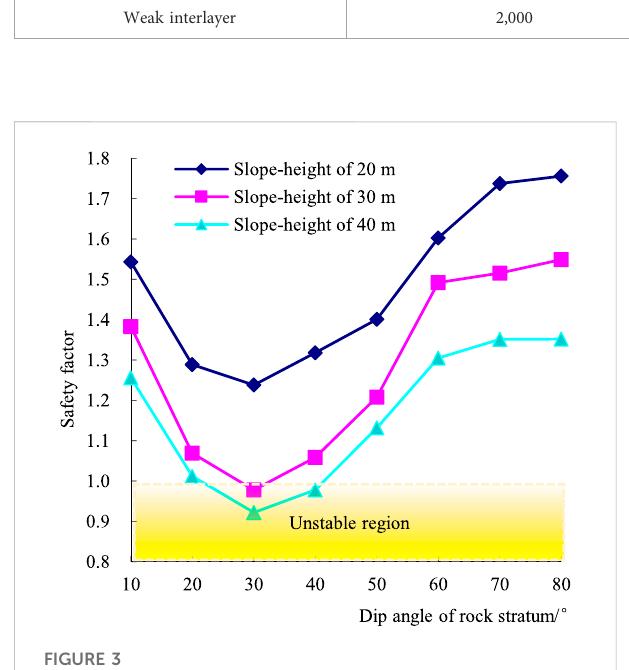
FIGURE 3 The in fl uence of interlayer angle on safety factor at different slope